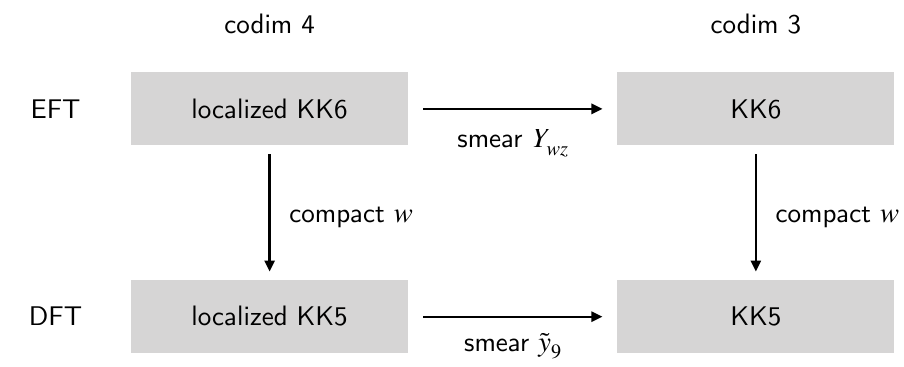
Figure 1 . The localized and the ordinary KK5- and KK6-branes in DFT and